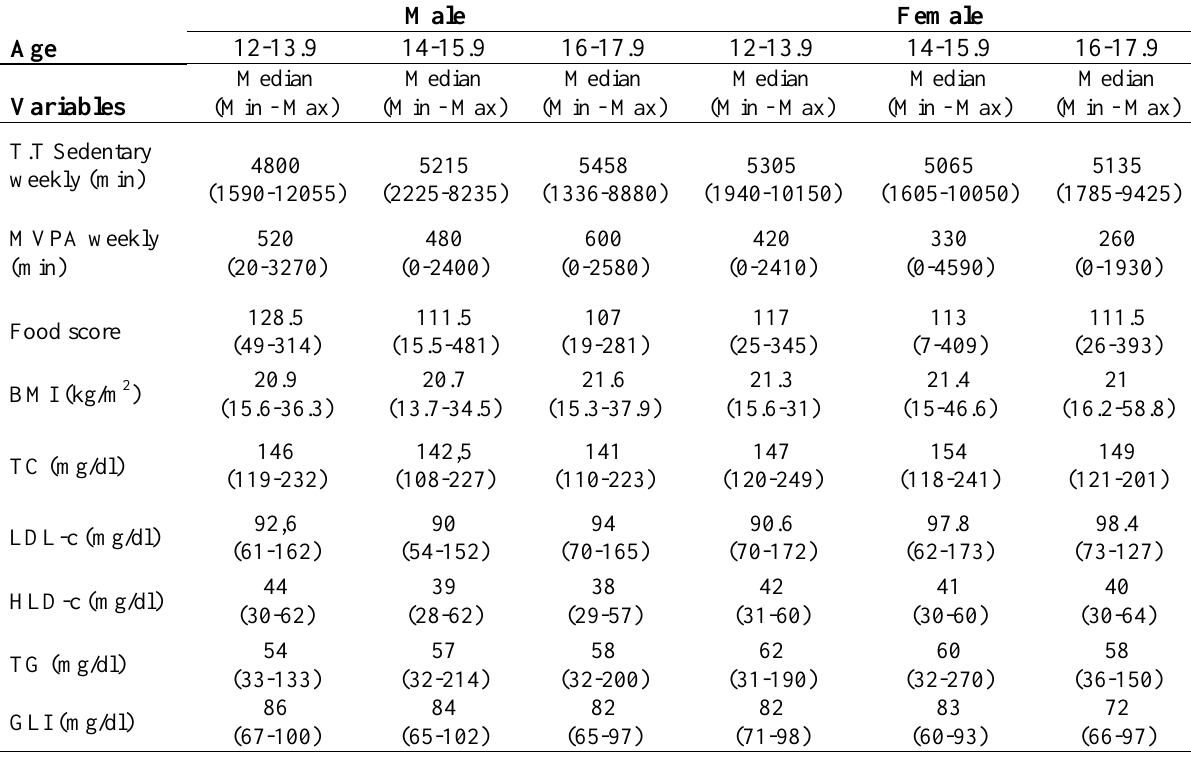
Table 2. Sample characteristics by sex and age group (N=